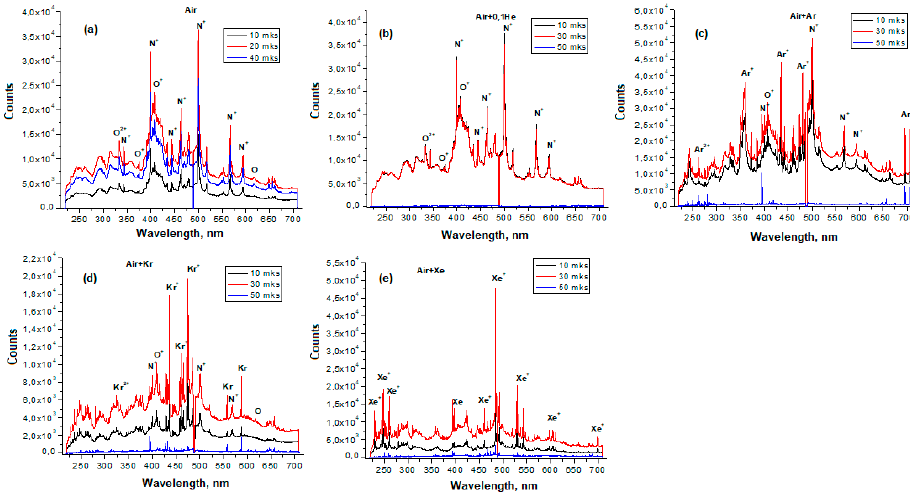
Figure 3. Emission spectra of air and its mixtures with inert gases in LIDB plasma: ( a ) pure Air; ( b ) Air + He: ( c ) Air + Ar; ( d ) Air + Kr; ( e ) Air + Xe.